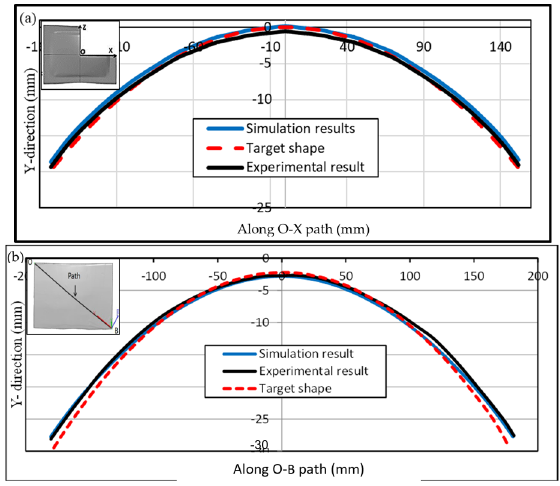
Figure 8. Comparisons between the simulation, experimental, and target shape at ( a ) O-X side, ( b ) at OB path.